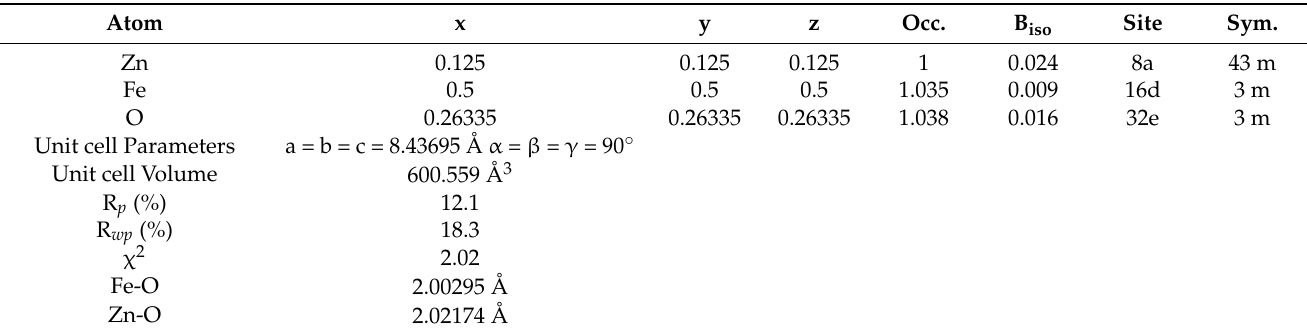
Table 1. Refined unit cells parameters of ZnFe 2 O 4 nanoparticles.